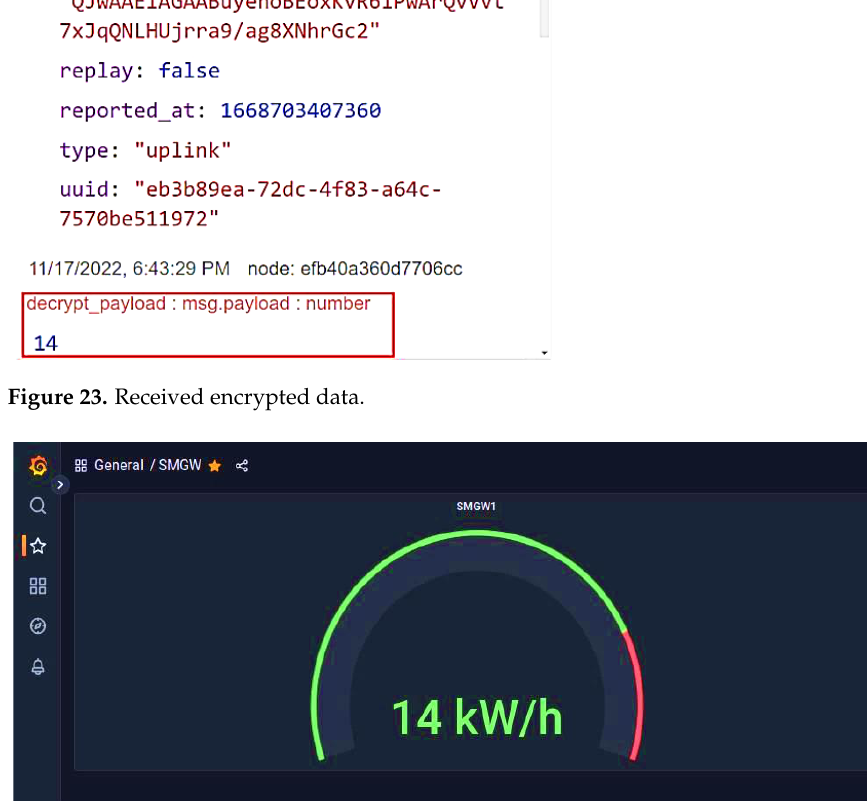
Figure 24. Dashboard